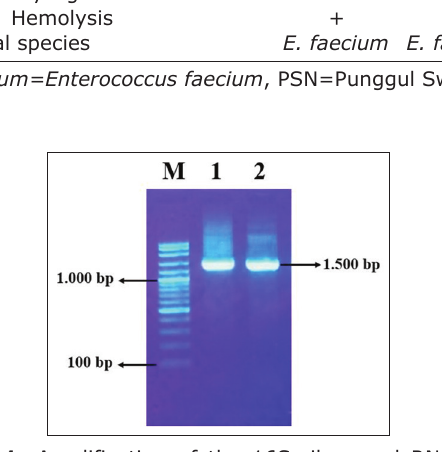
Figure-1: Amplification of the 16S ribosomal RNA gene of Gram-positive β hemolytic bacteria isolated from nasal of pig in 1% agarose. M: Marker 1kb, 1: PSN 2 isolate, 2: PSN 19 isolate. PSN=Punggul Swab